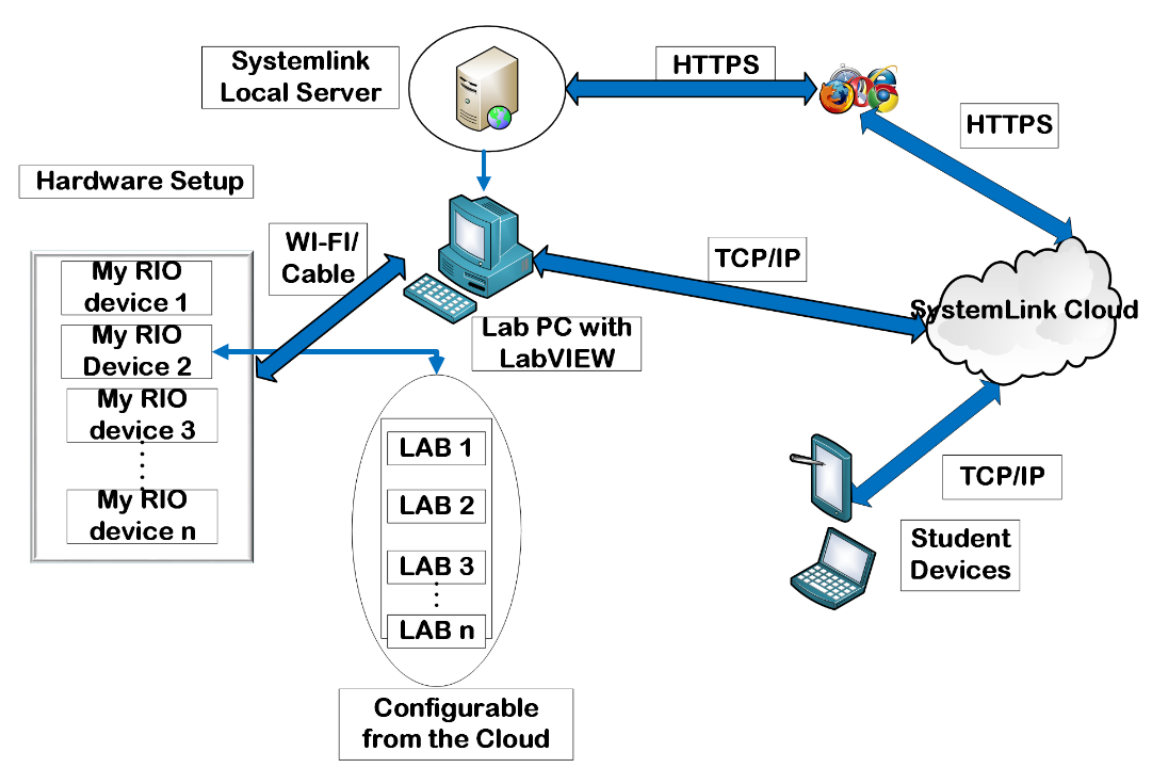
Figure 2. Laboratory platform structure.